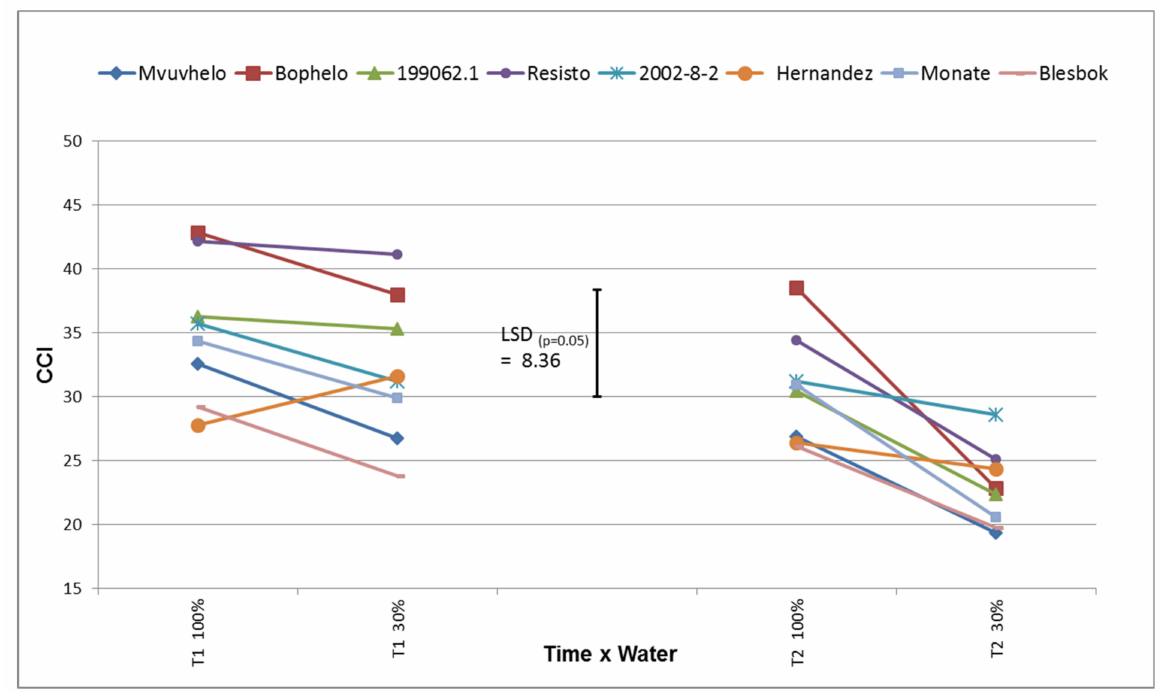
Figure 6. Chlorophyll content index (CCI) of eight sweet potato cultivars subjected to drought stress. LSD = 8.36; T1 = 60 days after planting; T2 = 120 days after planting. 100% = control treatment; ( p = 0.05) 30% = severe stress